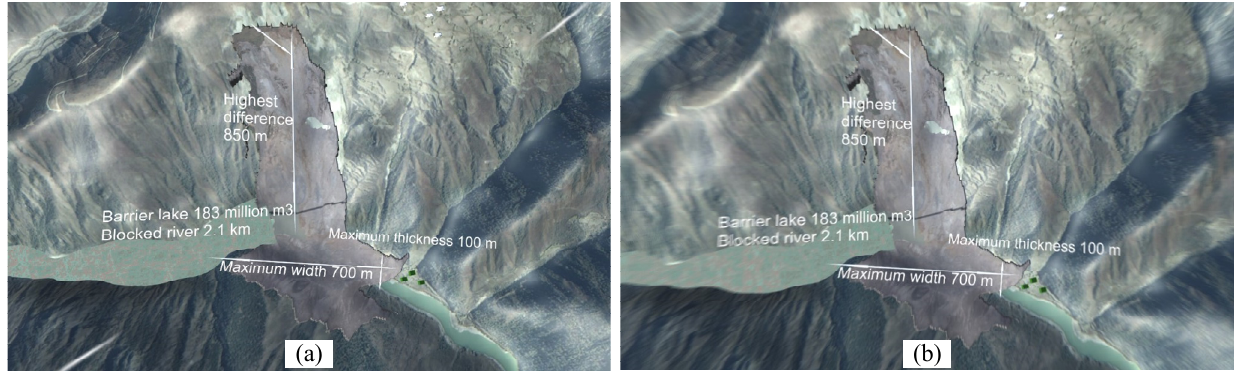
Figure 8. Comparison of visualization effects between original and optimized scenes. ( a ) Original scene, ( b ) optimized scene.